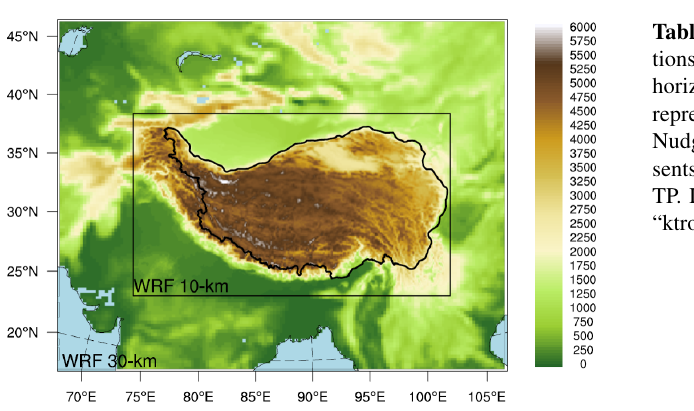
Figure 1. WRF domains and model topography (m). Solid black line in WRF 10km domain represents the boundary of the TP.